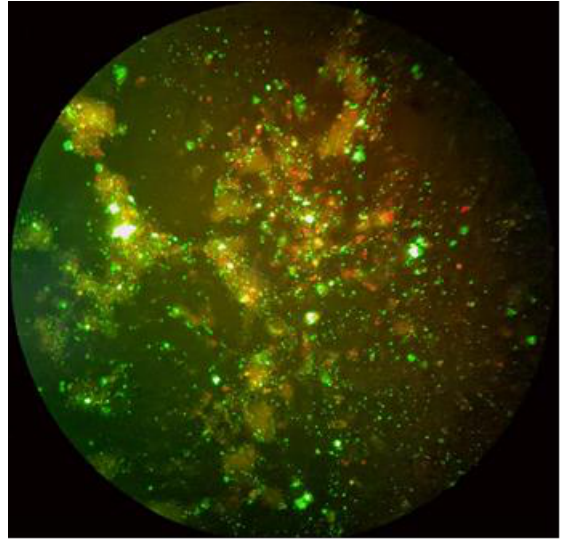
Figure 3. Liver cell smear positivity to Chlamydia spp. (apple green) detected by a direct Immuno- fluorescence test (40×).